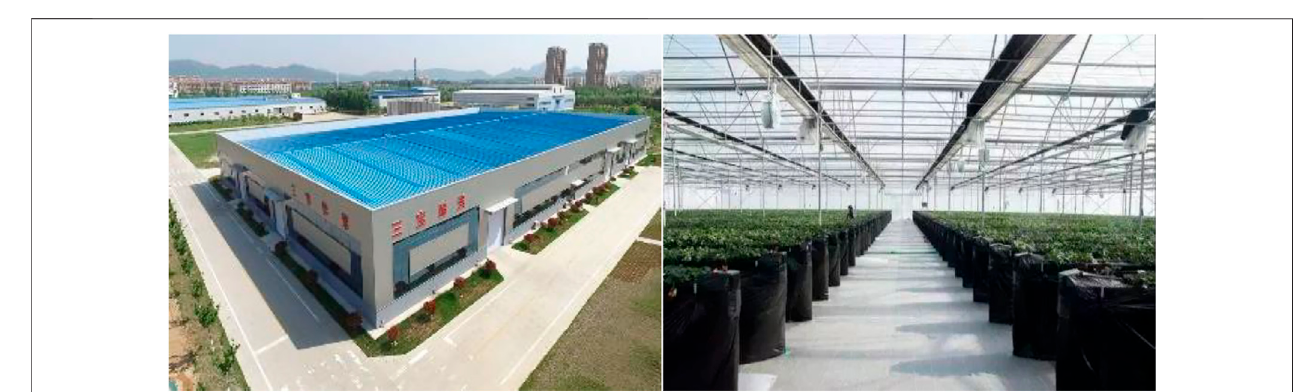
FIGURE 5 | Industrialized agriculture